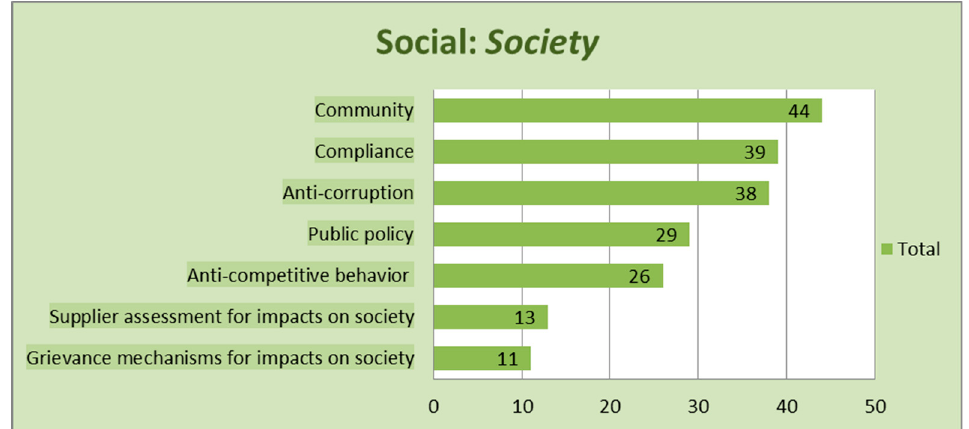
Figure 3. Tallies of occurrence of the social sustainability indicators from the society category.